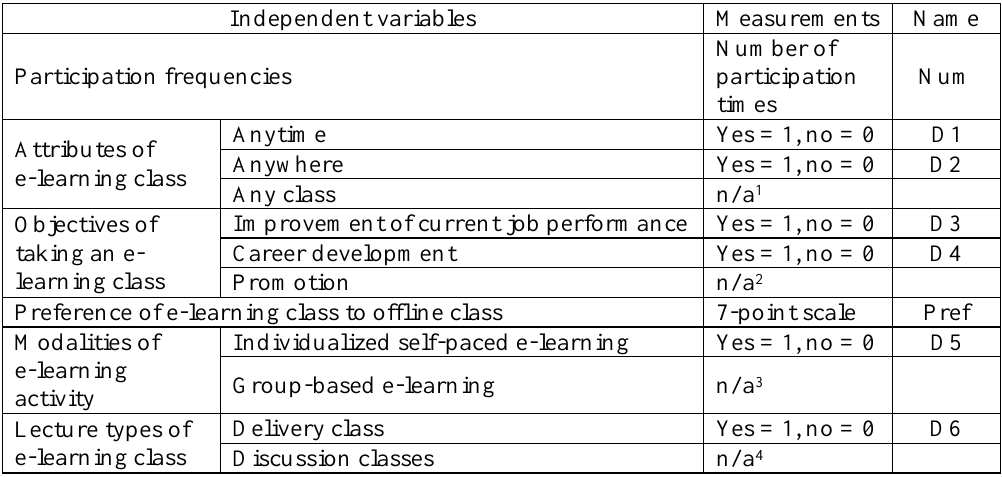
Independent Variables and Their Measurements Independent variables Measurements Name